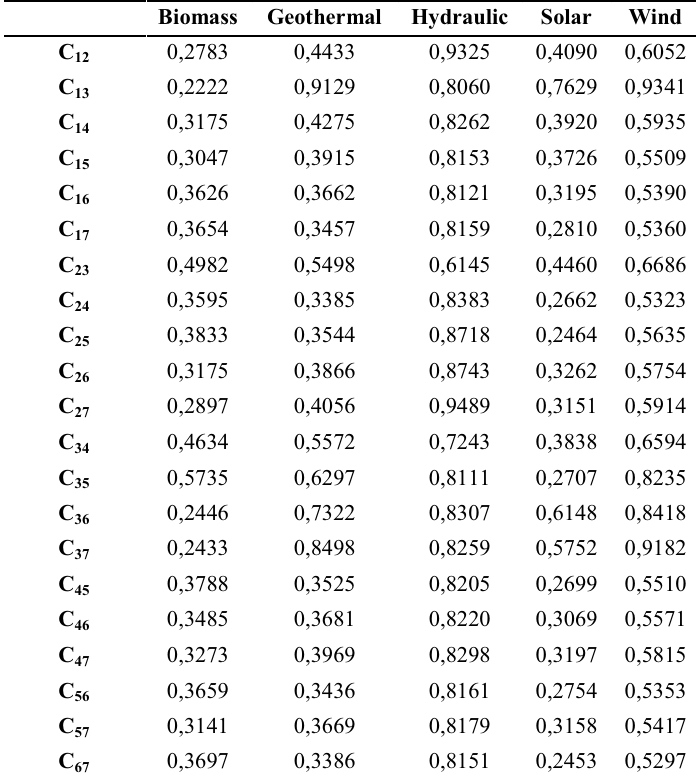
Table 9: Relative closeness values Biomass